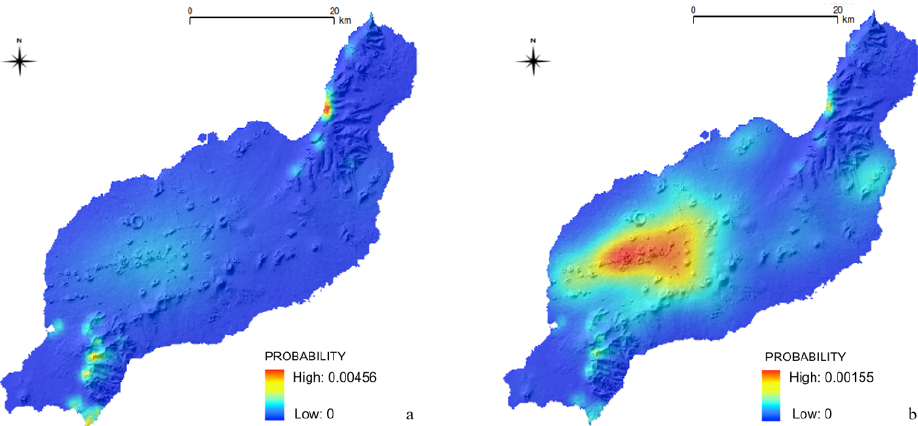
Fig. 12. Lanzarote susceptibility maps calculated assigning the same weights to all PDFs (a) and variable weights, i.e., 0.05 for dykes, 0.15 for the oldest vent alignments, 0.3 for the most recent vent alignments and 0.5 for the emission centers (b) .